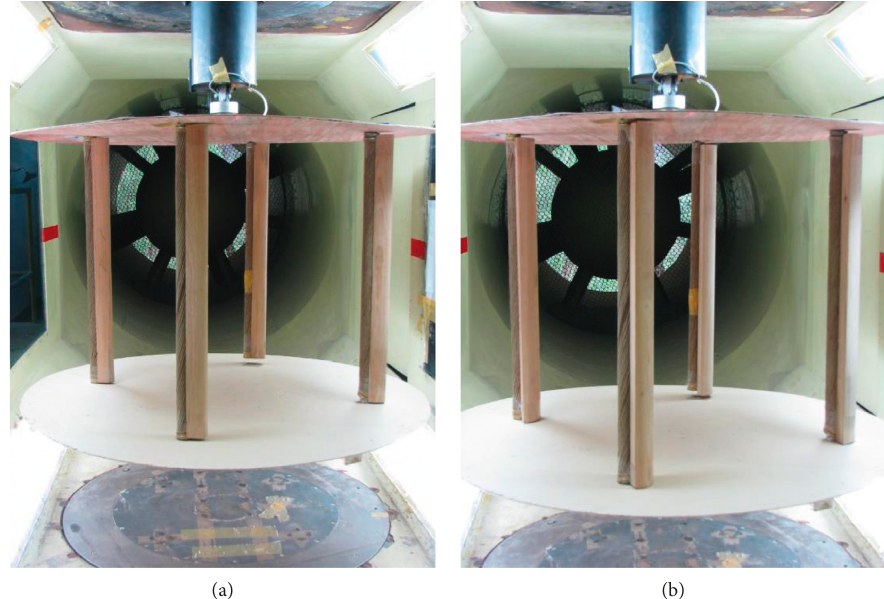
Figure 3: Photos of iced 4-bundle conductors in wind tunnel: (a) crescent-shape iced conductors and (b) sector-shape iced conductors.